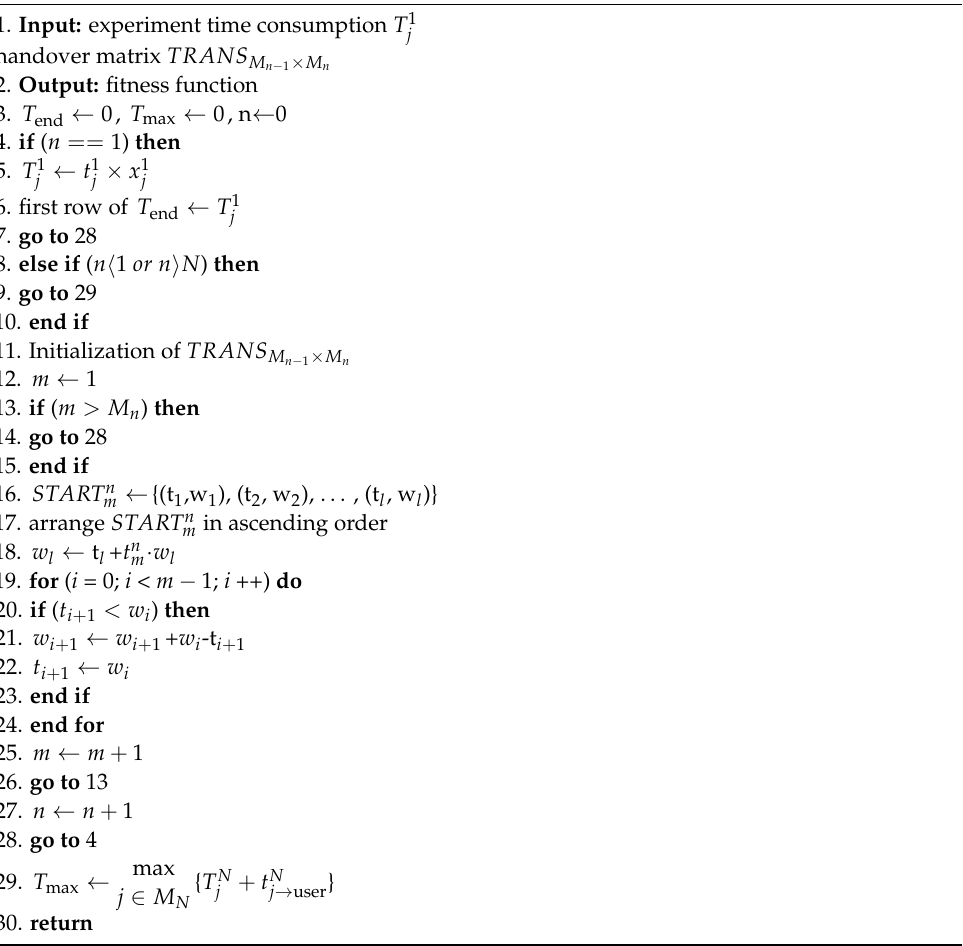
Algorithm 6. The Algorithm of Fitness Function